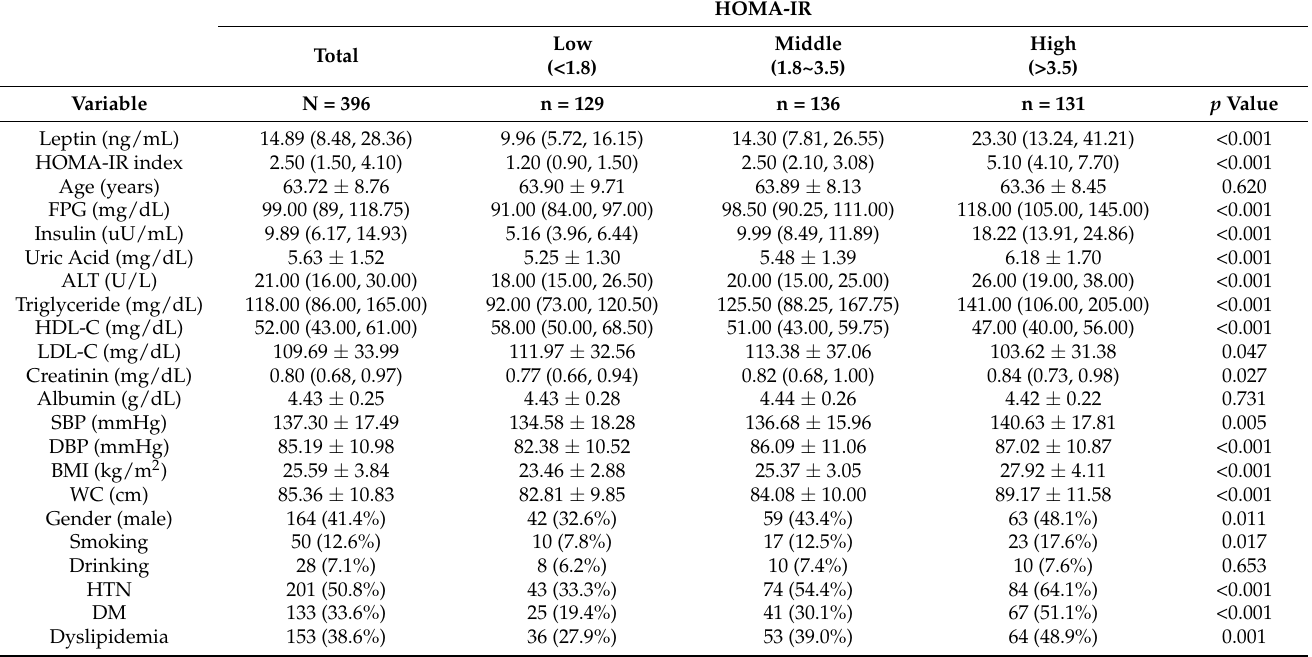
Table 1. Characteristics of participants according to the tertiles of the HOMA-IR index. Total